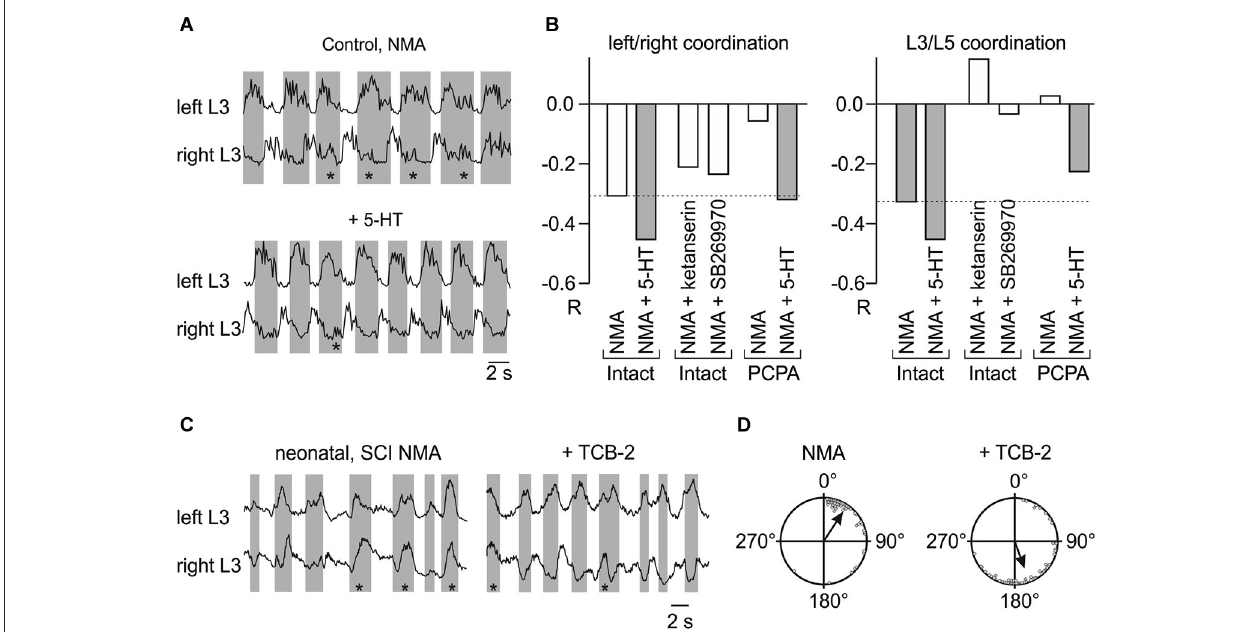
(C,D) Activation of 5-HT 2A receptors in vitro restores the left-right alternating locomotor pattern 5 days after neonatal spinal cord transection. (C) Integrated recordings from the left and right L3 ventral roots at P5 in the presence of NMA (16 µ M) alone (note the high occurrence of synchronous bursts, asterisks) or together with 5-HT 2A receptor agonist (4-bromo-3,6-dimethoxybenzocyclobuten-1-yl) methylamine hydrobromide (TCB-2): (0.1 µ M). (D) Distribution of phase relationships between left and right ventral root bursts in NMA alone (Left) and NMA plus TCB-2 (Right) in all of the spinal animals (P5–P6; n = 6). (C) and (D) are adapted from Bos et al.